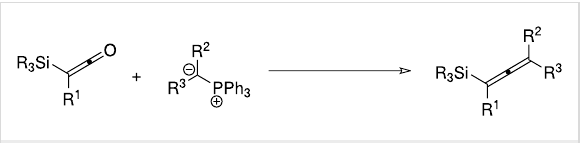
Figure 1: Alkylidenation approach to the synthesis of allenylsilanes.